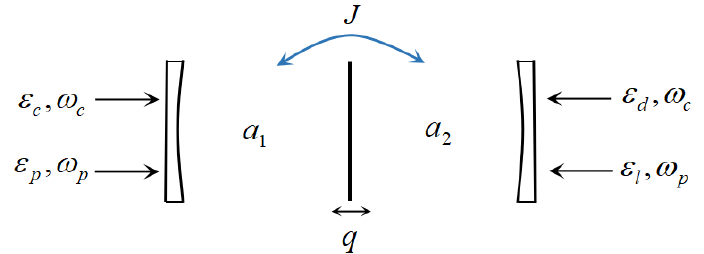
Figure 1. A three-mode optomechanical system, in which two cavities couple to a cubic anharmonic oscillator. Meanwhile, two cavities couple to each other with coupling strength J .